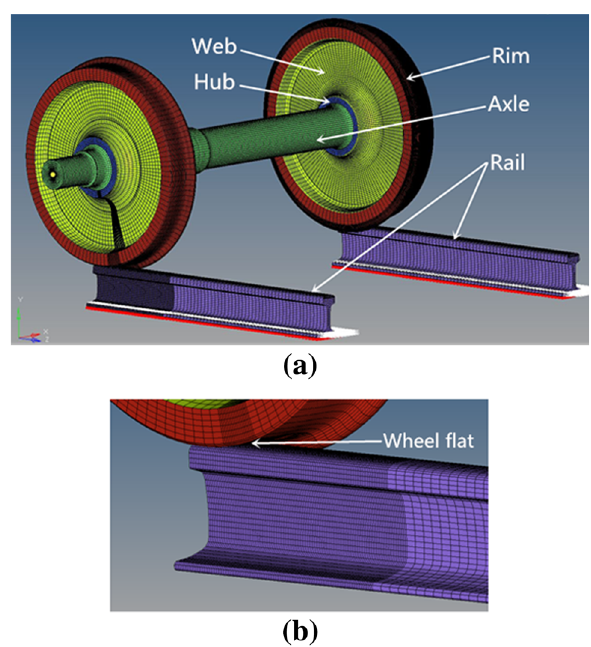
Fig. 1 FE model of the wheel–rail system with a 60-mm flat length. a Overall wheel–rail rolling contact model. b Enlarged view of the flat